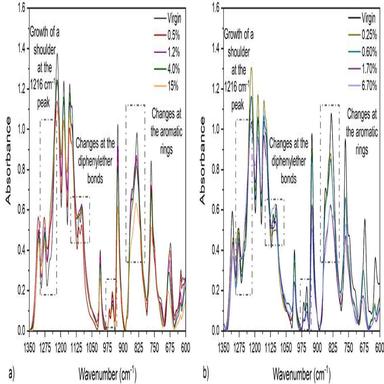
Spectral changes that occur at a) PEEK and b) CF-PEEK upon thermal degradation when heated with 50 ◦C/min up to a 0.5%, 1.2%, 4%, 15% and a 0.25%, 0.6%, 1.7%, 6.7% mass loss respectively (1350-600 cm-1).